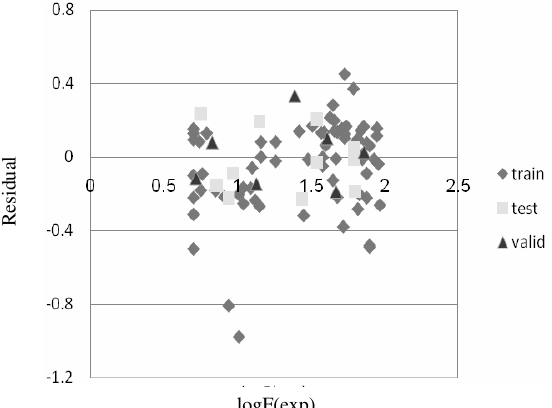
Figure 3. Plot of the residuals versus experimental values of logF for all molecules in data